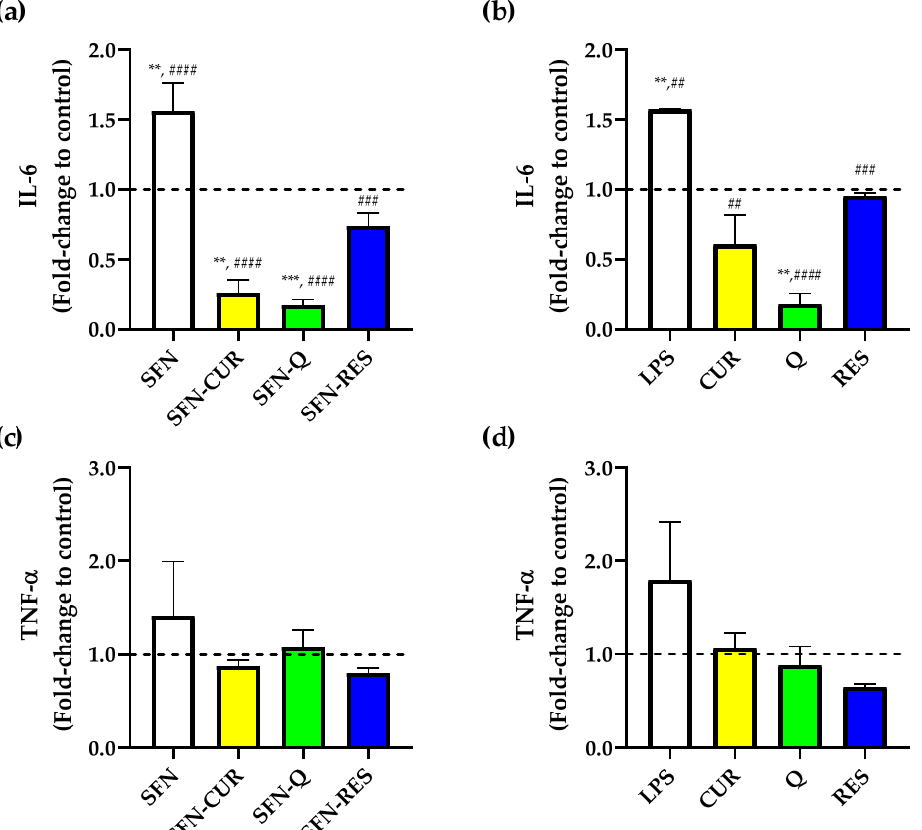
Figure 8. Effect of SFN-PPh and free compounds on cytokine release from the human macrophage HL-60 differentiated cells measured by ELISA. ( a ) IL-6 levels in SFN-PPh-treated cells, ( b ) IL-6 levels of free PPh-treated cells, ( c ) TNF- α levels of SFN-PPh-treated cells and ( d ) TNF- α levels in free PPh- treated cells (macrophage HL-60 differentiated cells under LPS-stimulated (0.1 µ g · mL − 1 ) conditions in the presence of nanoparticles (SFN or SFN-PPh (CUR, Q or RES) at 100 µ g · mL − 1 ) or free PPh (CUR, Q and RES) at the equivalent concentration (16 µ g · mL − 1 ) according the PLC. p -values were calculated using the two-way ANOVA test (considering p < 0.05 significant), followed by a Dunnet’s post hoc analysis. Values are expressed as fold-change to untreated cells (dash line). Results are represented as mean ± SEM from three different ELISA assays with three replicates performed in each assay condition. ** p < 0.01, *** p < 0.001 between treatments and untreated cells. ## p < 0.01, ### p < 0.001, #### p < 0.0001 between treatments and LPS-stimulated control. LPS, lipopolysaccharide; IL-6, interleukin 6; TNF- α , tumor necrosis factor alpha; SFN, silk fibroin nanoparticles; PPh, polyphenols; SFN-CUR, SFN-curcumin loaded; SFN-Q, SFN-quercetin loaded; SFN-RES, SFN-resveratrol loaded; CUR, curcumin; Q, quercetin; RES,